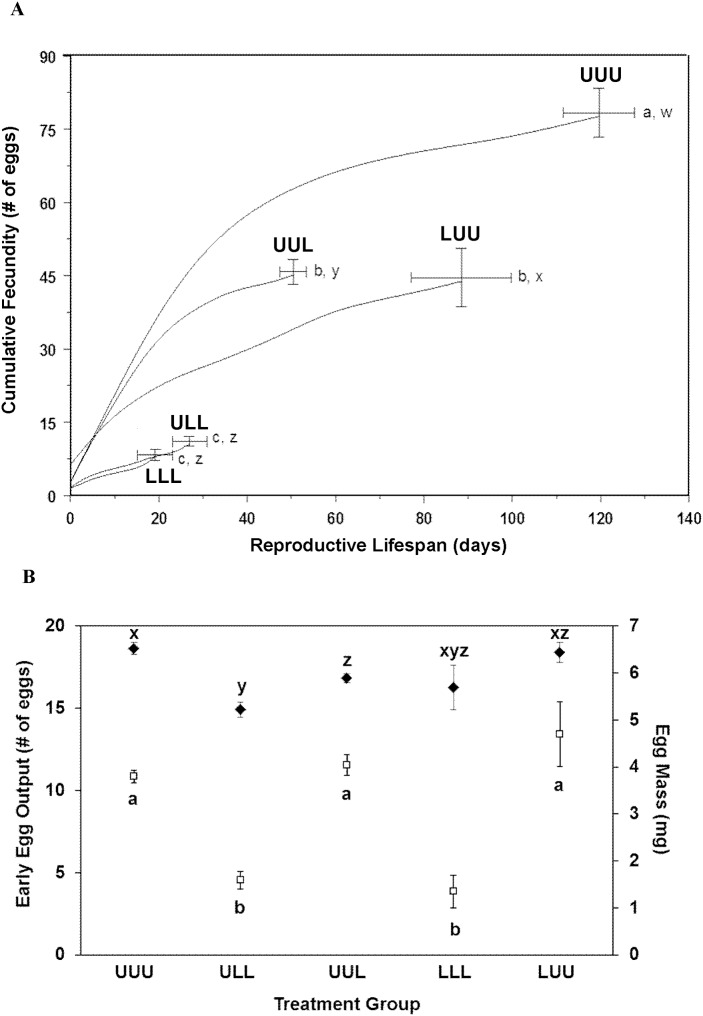
Reproductive performance.(A) Cumulative fecundity of insects in each of five treatment groups. The x-axis represents days of the reproductive lifespan. Each curve terminates at a point corresponding to the mean duration (± standard error) of reproductive activity and the mean fecundity (± standard error) for each group. Curves were constructed by scaling the reproductive lifespan of each insect to the mean reproductive lifespan for that group, determining the mean cumulative fecundity of all insects in that group on each day of the scaled reproductive lifespan, and fitting a smooth spline (df = 7) to the resulting means. U = unlimited access to food, L = limited access to food. Sample sizes: UUU n = 13, ULL n = 13, UUL n = 13, LLL n = 7, LUU n = 12. Different letters to the right of each point indicate significantly different means for fecundity (a, b, and c) and reproductive lifespan (w, x, y, and z) among treatment groups. (B) Metrics of egg production. Early egg output (white squares) was measured as the number of eggs oviposited during the first six days of the reproductive lifespan, and mean egg mass (black diamonds) was measured in mg (means ± standard errors). U = unlimited access to food, L = limited access to food. Sample sizes: UUU n = 13, ULL n = 13, UUL n = 13, LLL n = 7, LUU n = 12. Different letters indicate significantly different means for early egg output (a, b, and c) and mean egg mass (x, y, and z) among treatment groups.